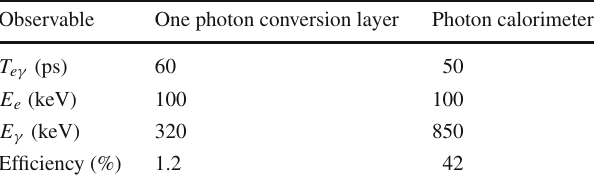
Table 7 Expectedperformances (efficiencyandresolutions) for abasic design with different options as discussed in the text Observable